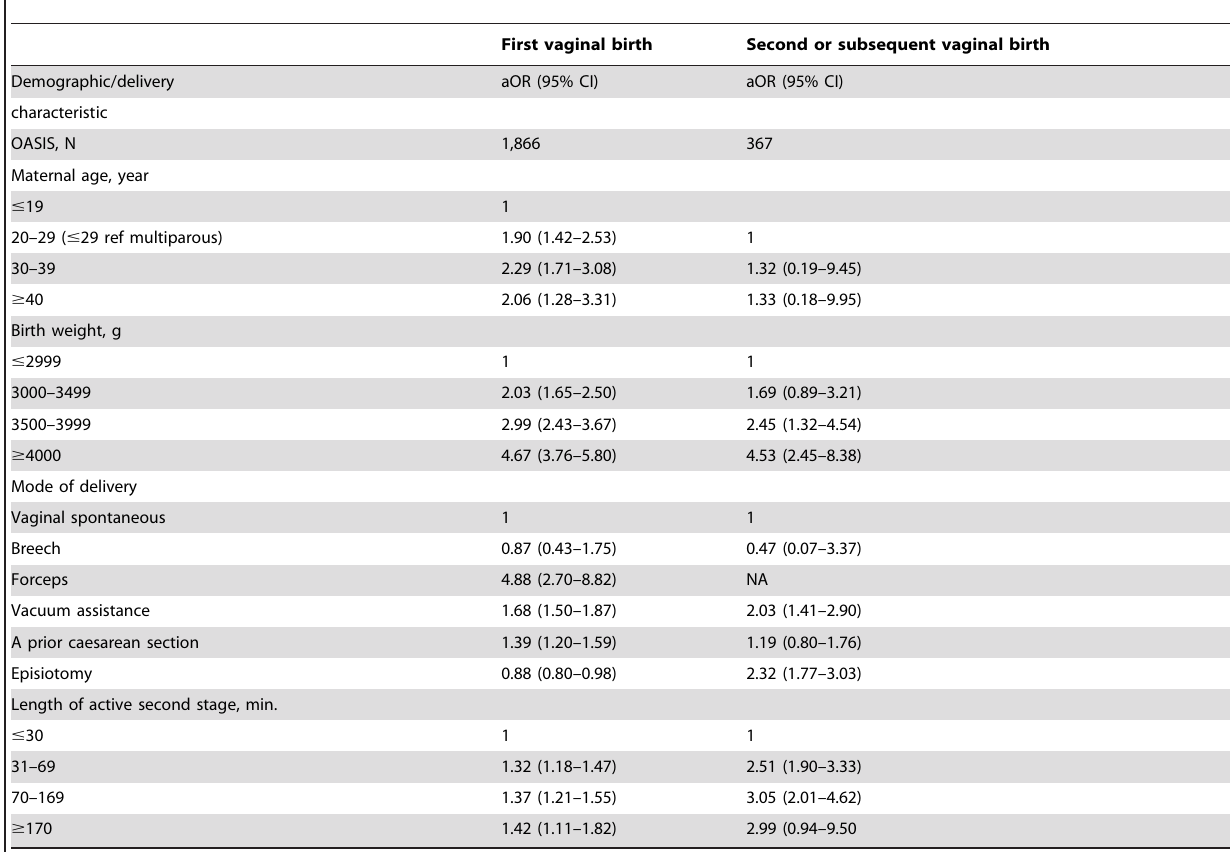
Table 3. Adjusted odds ratios (aOR) of OASIS among women with first vaginal singleton births including women with first vaginal birth after a prior caesarean section (n= 131,006) and among women with second or subsequent births (n=172,710) in 2004–2011 in Finland (logistic regression